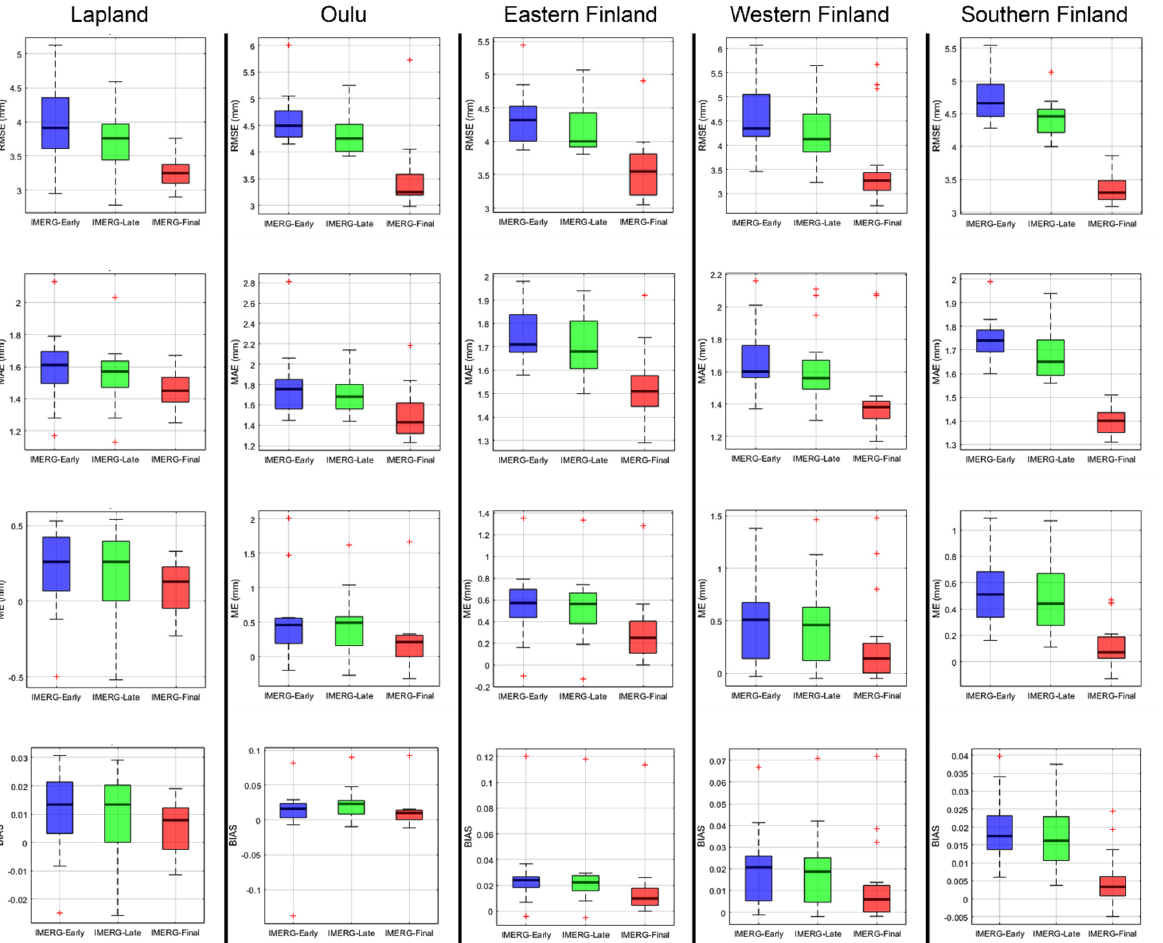
Figure 9. Boxplots comparing the errors associated with SPP estimates using RMSE, MAE, ME, and BIAS for each region in Finland.